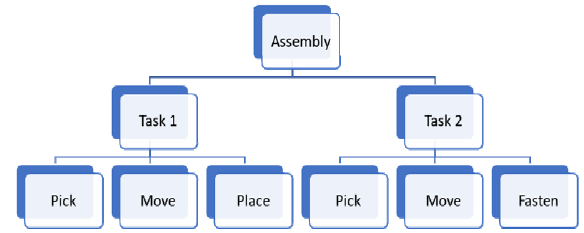
Figure 2. Hierarchical model of assembly job, tasks and